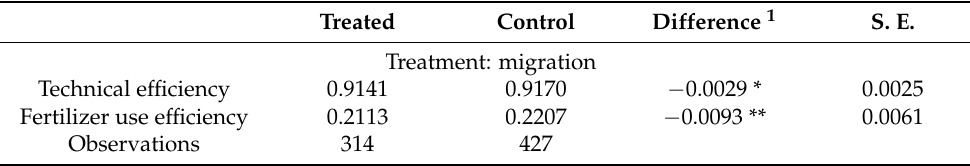
Table 2. The effect of migration on technical efficiency and fertilizer use efficiency. Treated